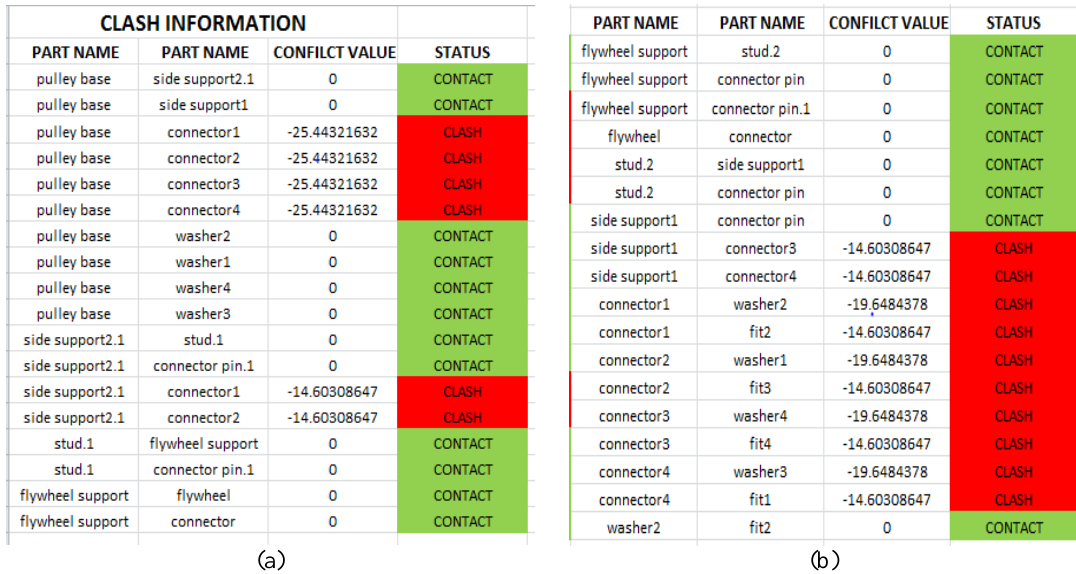
Figure 6. (a) and (b) represent the clash information of pulley